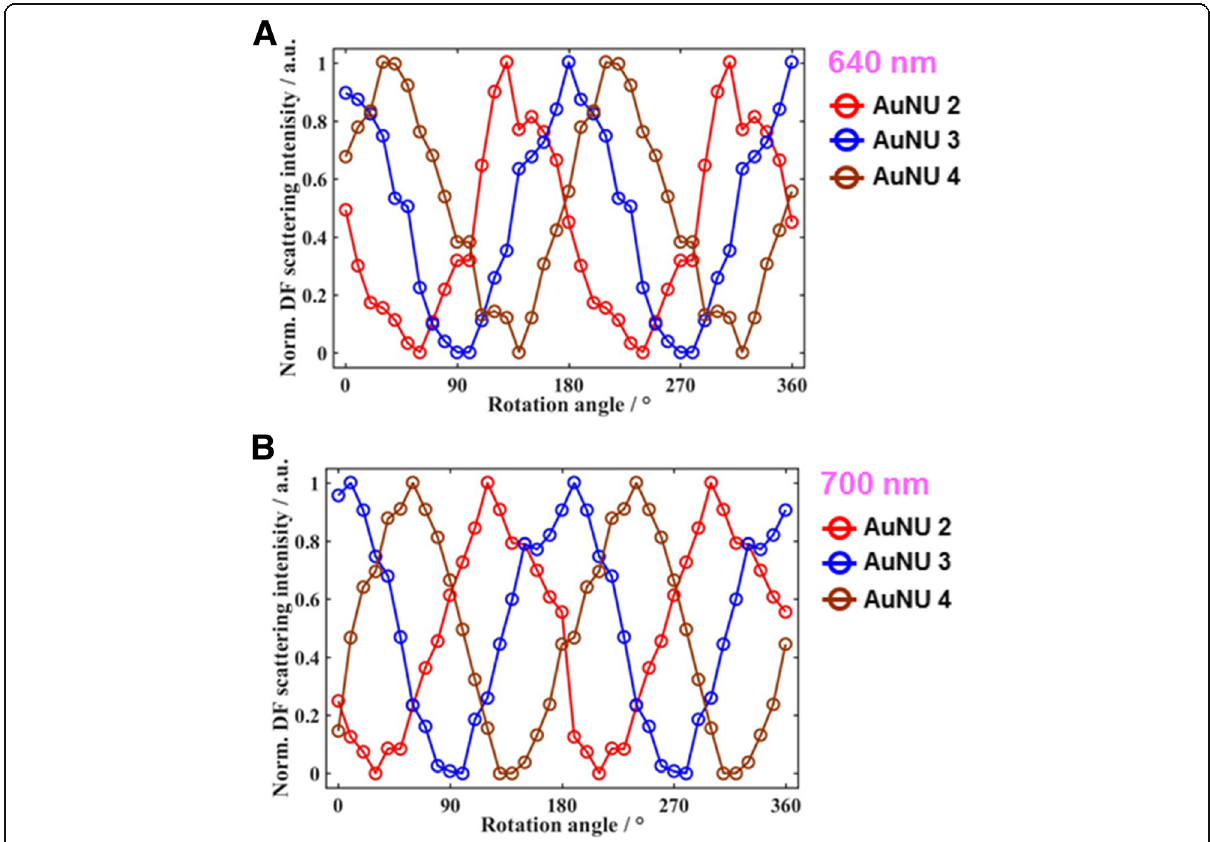
Fig. 5 a Changes in the normalized scattering intensities for three AuNUs (AuNU2 to AuNU4) at 640 nm as a function of the rotational angle. b Changes in the normalized scattering intensities for three AuNUs (AuNU2 to AuNU4) at 700 nm as a function of the rotational